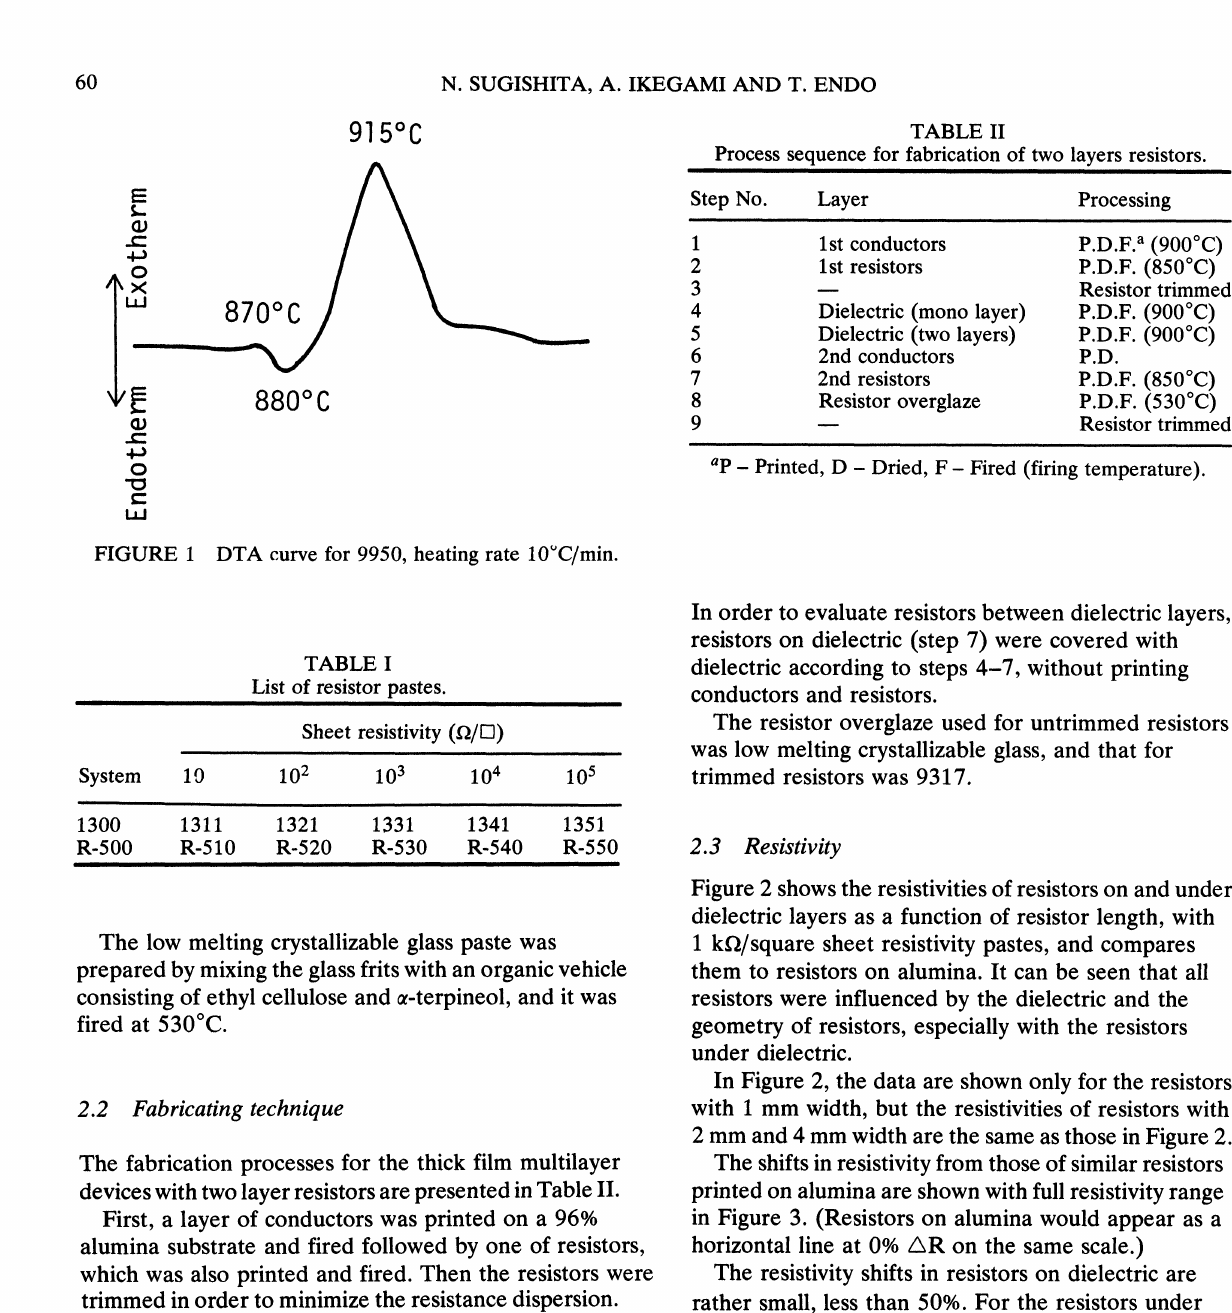
TABLE II Process sequence for fabrication of two layers resistors.